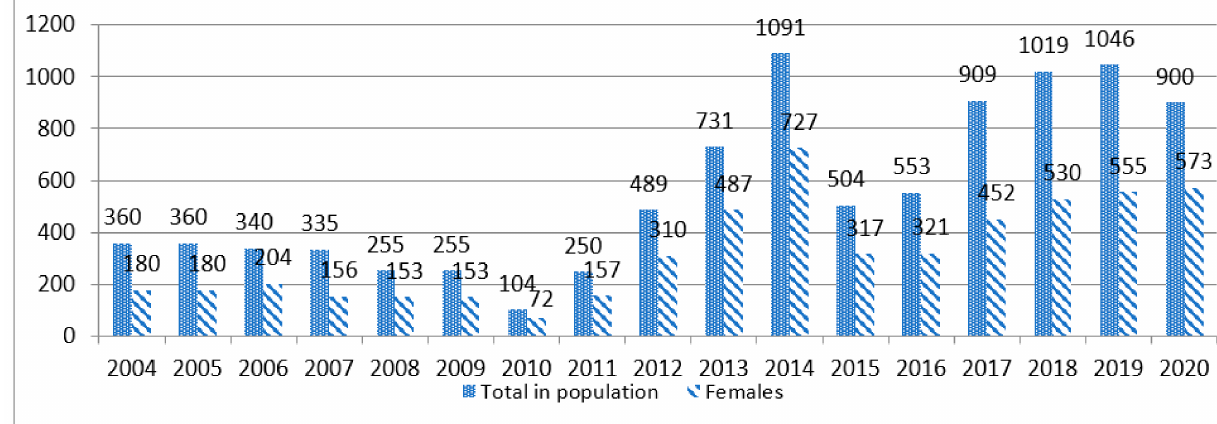
Figure 2. Vištin˙es geese numbers from 2004 to 2020.